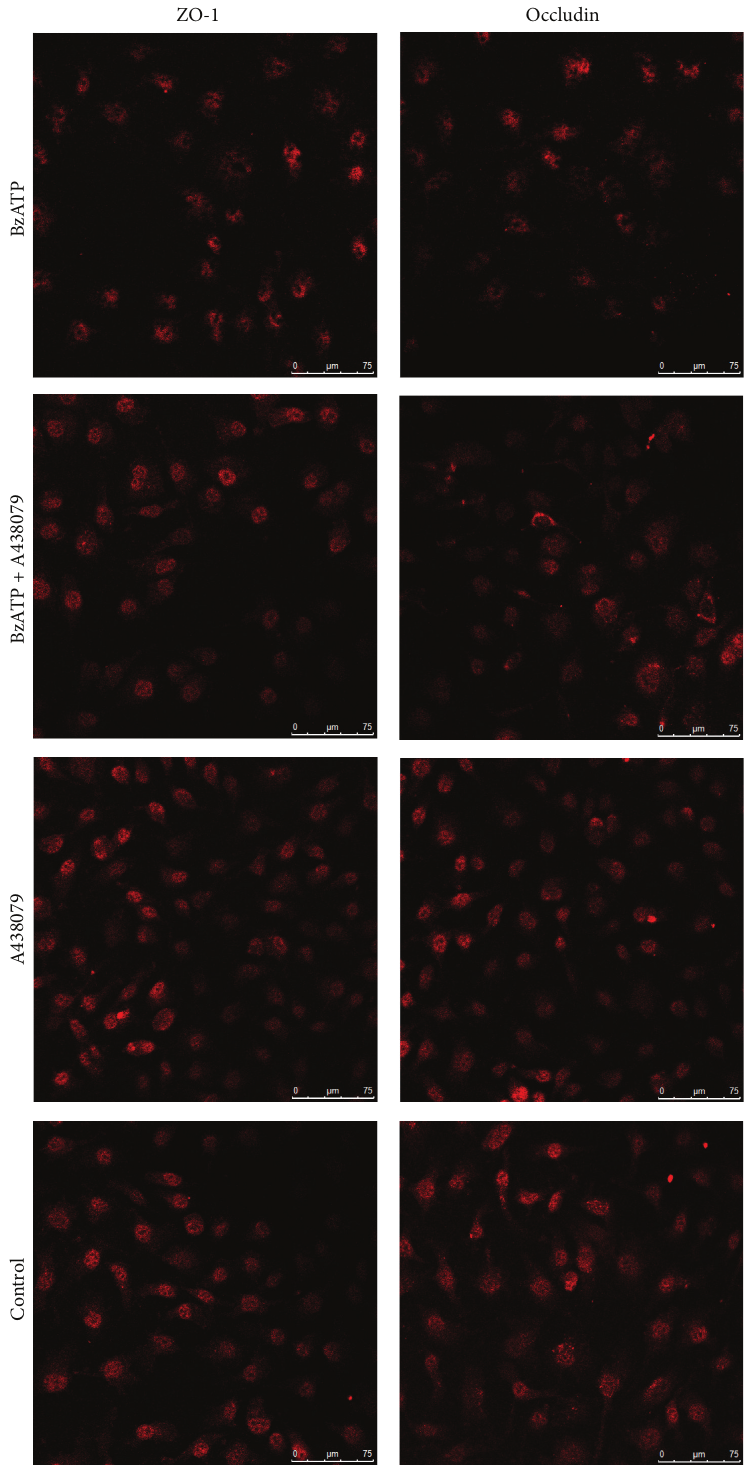
Figure 2: Confocal microscopy images of immunofluorescence staining of ZO-1 and occludin in hCMEC/D3 cells demonstrating the protective effect of A438079 against BzATP-induced tight junction